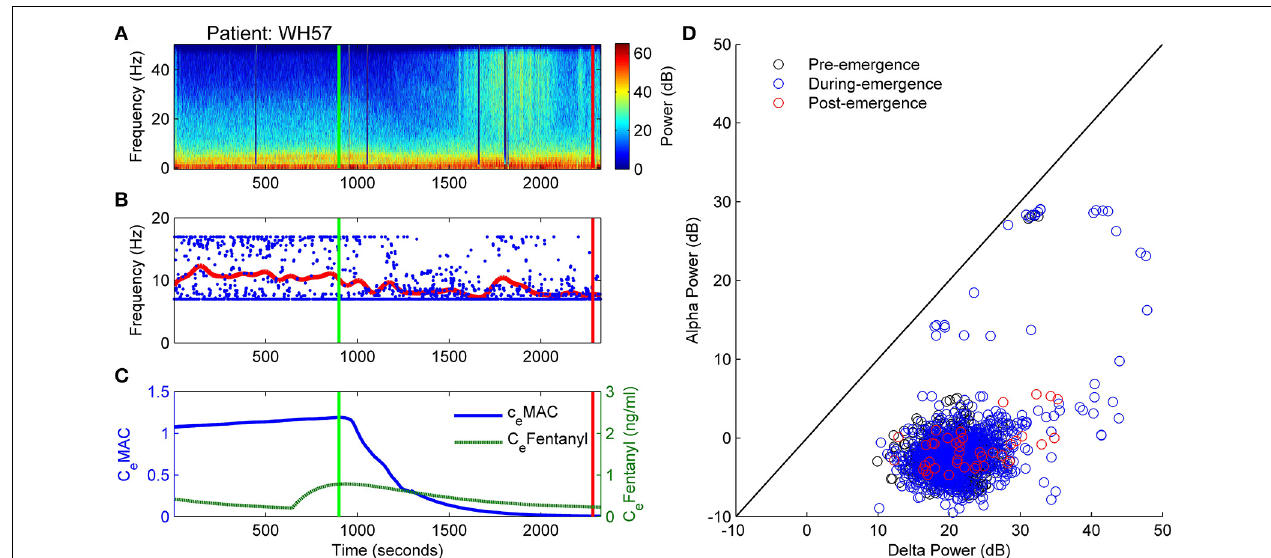
FIGURE 10 | Patient WH57: Non-archetypal emergence (no alpha, persistent delta, periods of high frequency activity). (A) Spectrogram of the observation period. Start of emergence shown as a vertical green line at 900s, time of patient response as a vertical red line. (B) Frequency of maximal oscillatory alpha power. (C) Concentration of anesthetic gas